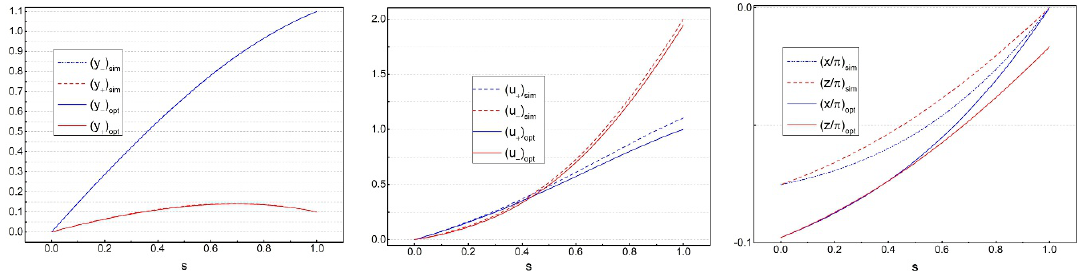
Figure 4 . Example of geodesics preparing a target state with both a (cid:6) nonvanishing. We compare the optimal geodesic and the \simpler" geodesic with z 1 = 0. In this example, both geodesics have the (cid:12)nal boundary conditions: y +1 = 0 : 1 ; y (cid:0) 1 = 1 : 1 ; (cid:3) + = 1 : 105 ; (cid:3) (cid:0) = 6 : 008. For the optimal geodesic, we also have x 0 = z 0 = (cid:0) 0 : 0976 (cid:25); x 1 = 0 ; z 1 = (cid:0) 0 : 0167 (cid:25) , while for the \simpler" one, x 0 = z 0 = (cid:0) 0 : 0749 (cid:25); x 1 = 0 = z 1 . Note that y (cid:6) essentially coincide in both geodesics, as shown in the far left